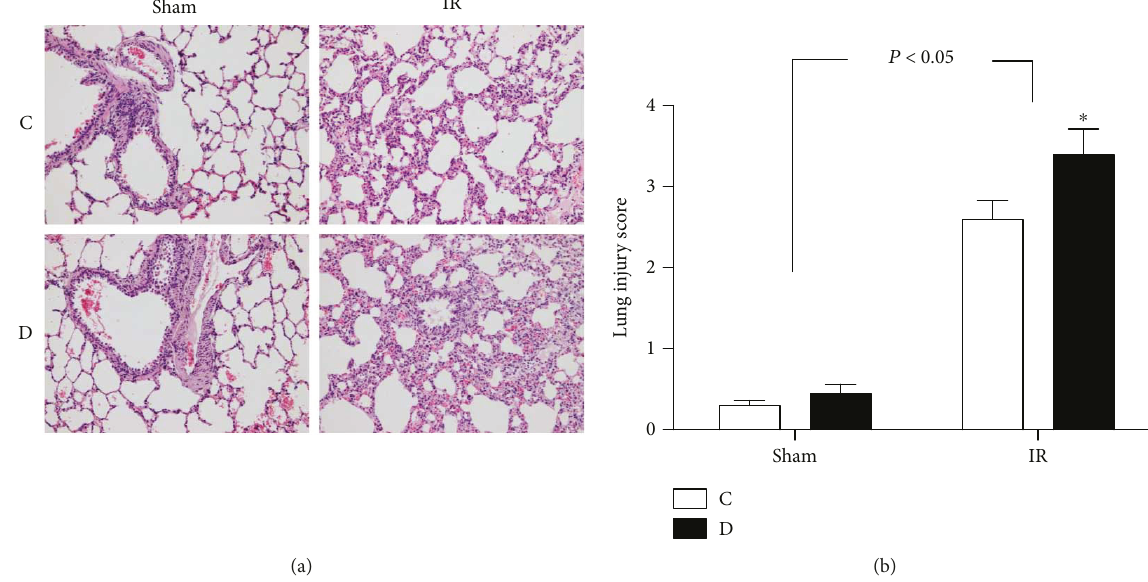
Figure 2: Histopathologic changes in rat lungs from control and diabetic rats subjected to sham or myocardial ischemia reperfusion (IR) operation under light microscopy. (a) Representative photomicrographs of hematoxylin and eosin (HE) staining (original magni fi cation × 200). (b) Severity of lung injury expressed as injury score. All values are expressed as means ± S.D., n = 8 . ∗ P < 0 05 versus the corresponding C